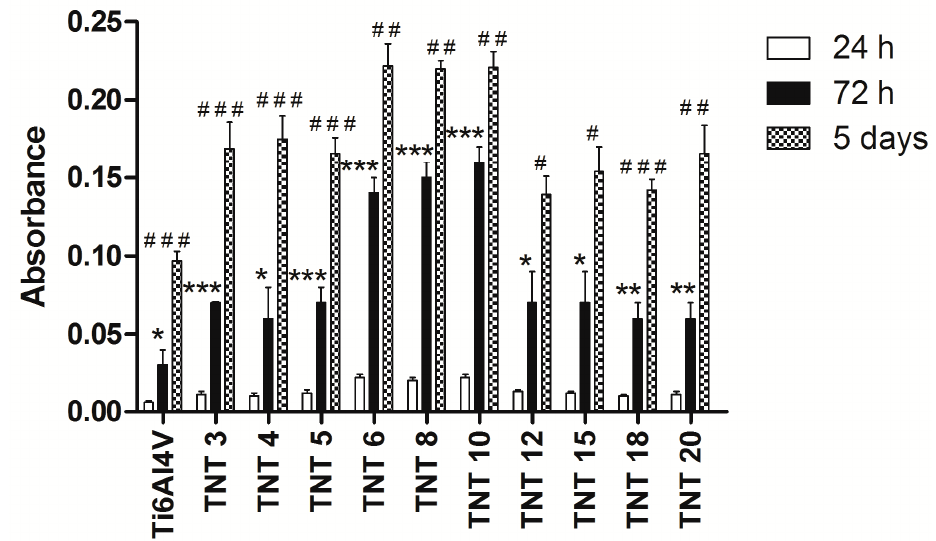
Figure 4. The effect of the incubation time on the murine L929 fibroblasts adhesion (after 24 h) and proliferation (after 72 h and 5 days) on the surfaces of Ti6Al4V alloy foils, modified by TNT, detected by MTT assays. The absorbance values are expressed as means ± S.E.M. of three experiments. Asterisk indicates significant differences between the cells incubated with the respective TNT for 24 h compared to 72 h of incubation time (* P < 0.05, ** P < 0.01, *** P < 0.001, respectively); hash mark denotes significant differences between the cells incubated with the same TNT for 72 h in comparison to 5 days’ incubation time ( # P < 0.05, ## P < 0.01, ### P < 0.001, respectively).